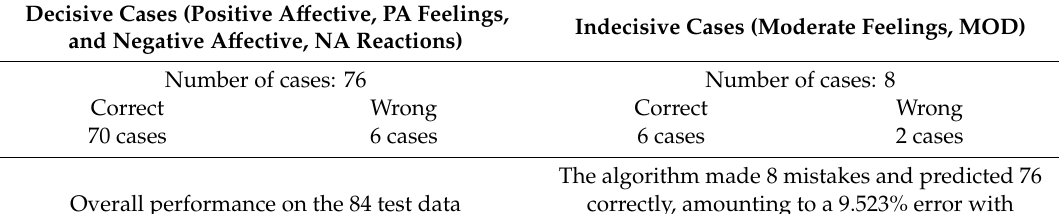
The algorithm made 8 mistakes and predicted 76 correctly, amounting to a 9.523% error with approximately 90.476% predictive